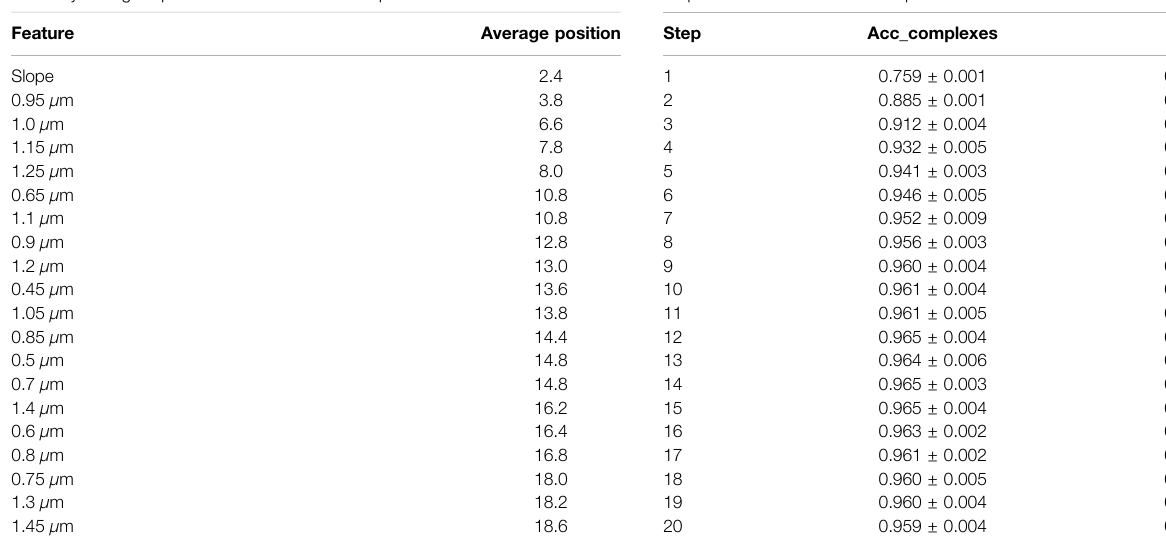
TABLE 6 | Average rank per feature for the classi fi cation of complexes with accuracy during sequential feature selection on spectral features.